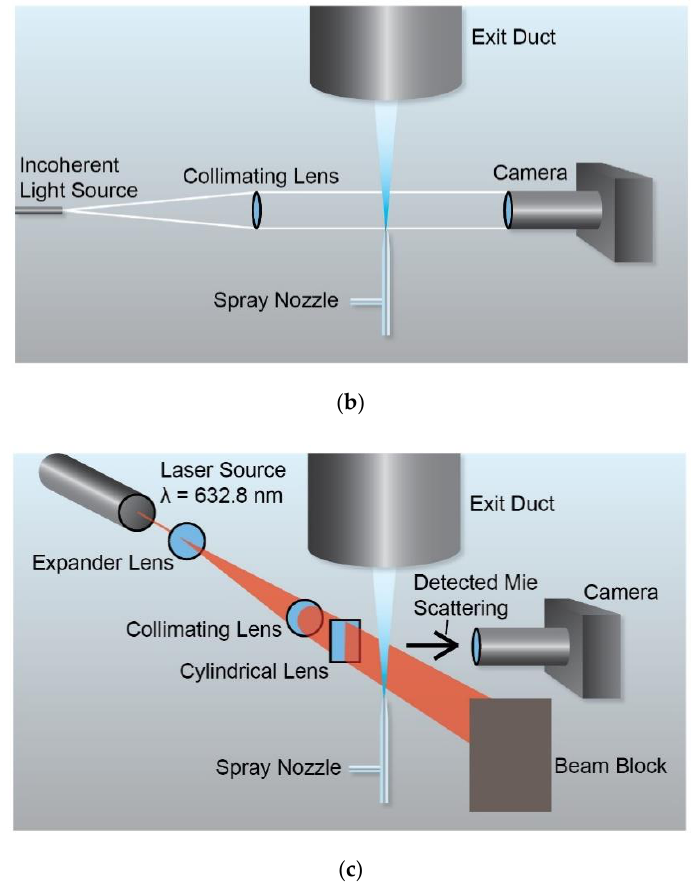
Figure 1. ( a ) Meinhard nebulizer for the aerated flows. ( b ) Shadowgraphy experimental setup. ( c ) Mie scattering experimental setup. The exit duct was used for the exhaust.